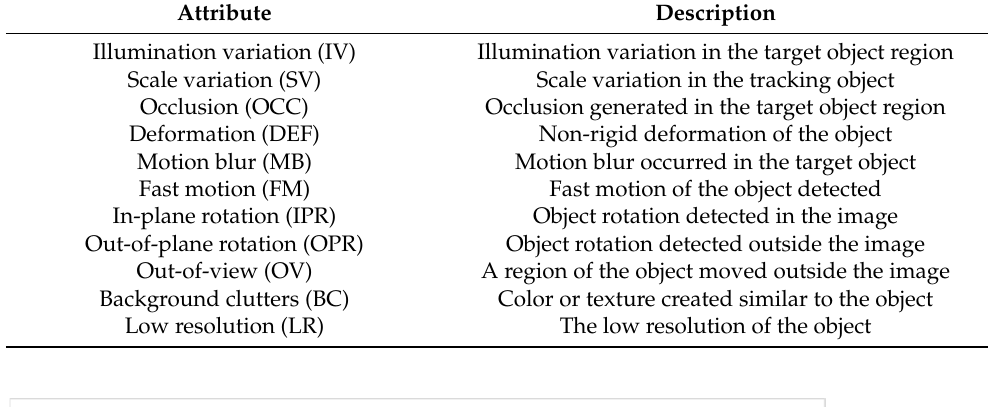
Table 3. Sequence Attribute Table for Algorithm Evaluations.